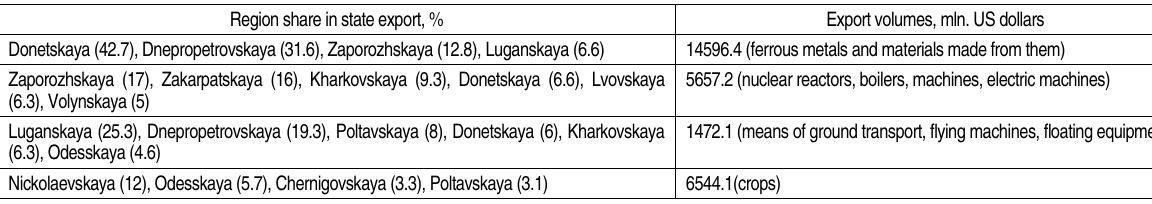
Table 8. Export volumes of the regions of Ukraine, 2014 Region share in state export, % Export volumes, mln. US